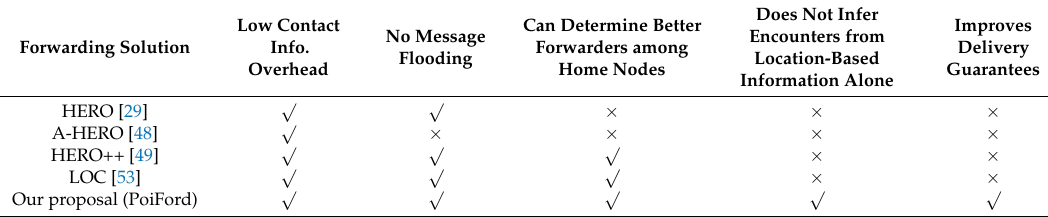
Table 3. Relevant forwarding solutions and their main